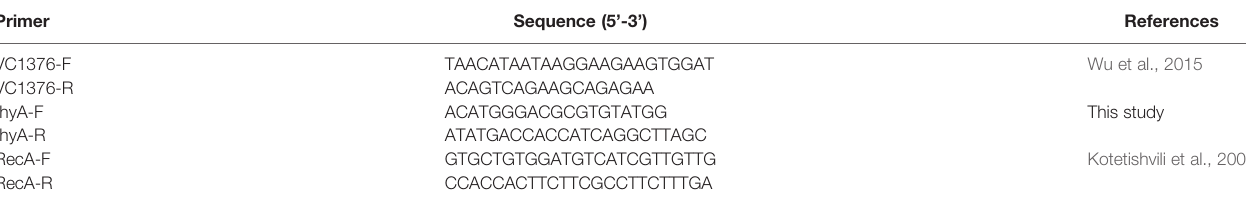
TABLE 1 | Oligonucleotides used in this study.